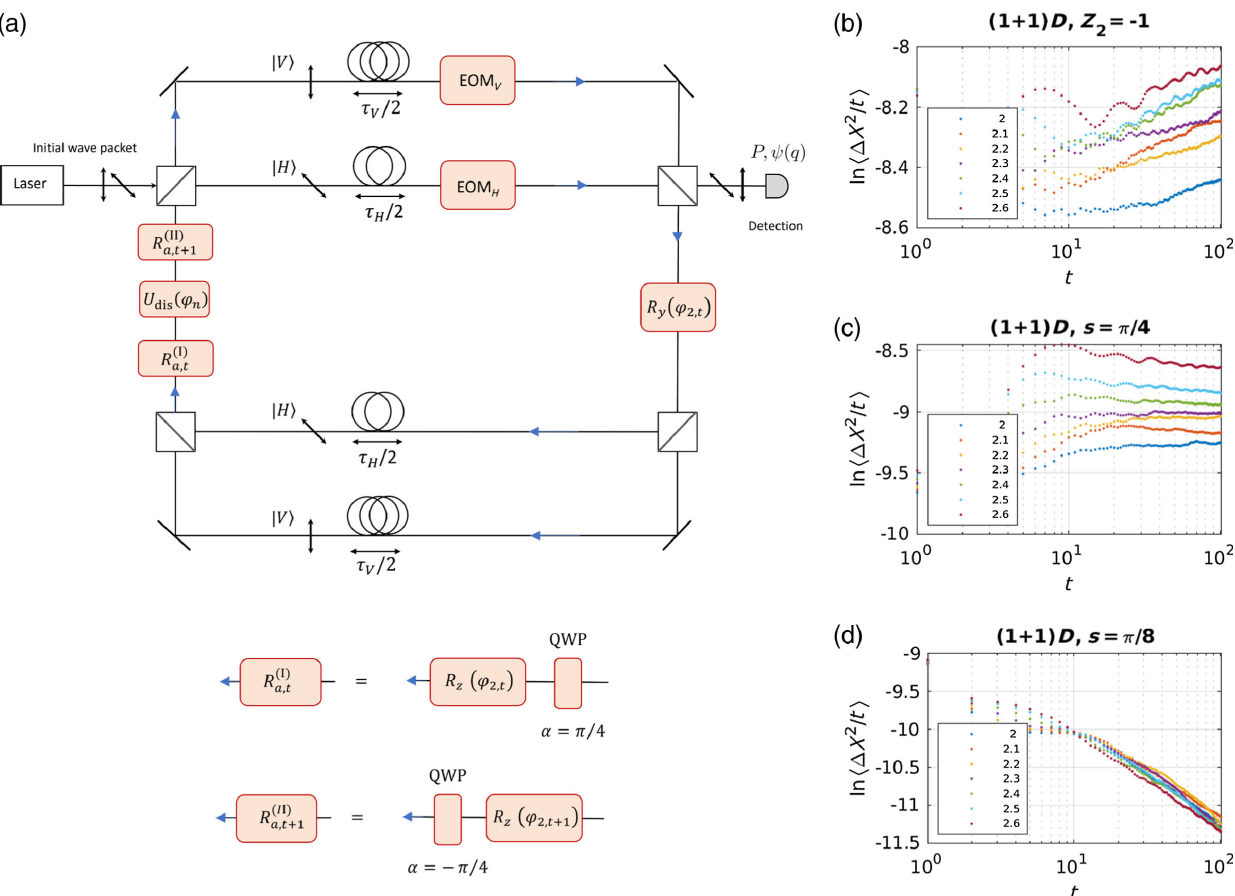
FIG. 7. Blueprint of an optical linear network simulating the topological surface states of a 3 D quantum spin Hall insulator in the ˆ T (cid:2) 1 2 quantum-walk setting. (a) Feedback loop built from the step operator C (upper and middle arms, respectively) and the coin operators ˆ R ˆ R and (right and left arms, respectively); for details, see main text. To the left and right of the loop, source and detection units are a b D quantum walk for short time steps accessible by connected. (b) Numerical simulation of a topological metal ( Z 2 ¼ − 1 ) in a ð 1 þ 1 syn Þ experiments. The width of the wave packet scaled by time is plotted on a log scale, showing that diffusion is anomalously fast. D class A at a topological quantum phase transition, showing the same scaling with the classical (c) Critical quantum walk in ð 1 þ 1 syn Þ D class A without a topological term, showing Anderson localization. Colors diffusion h Δ X 2 i ∼ t . (d) Quantum walk in ð 1 þ 1 ffiffiffi syn Þ p 5 C with values for C as indicated in the correspond to incommensurate frequencies ω 2 ¼